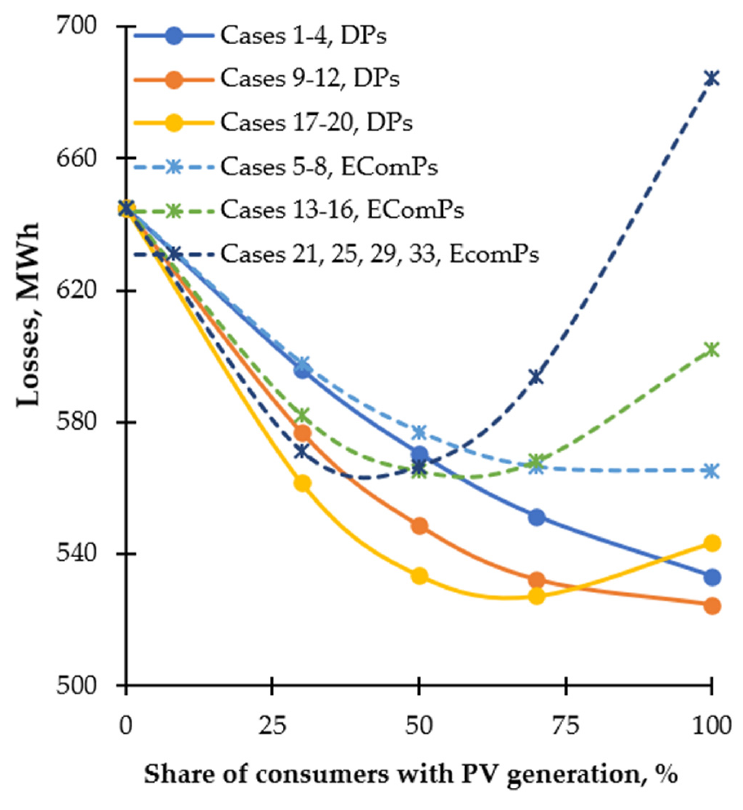
Figure 7. Yearly active energy losses for different cases, DPs vs. EComPs.